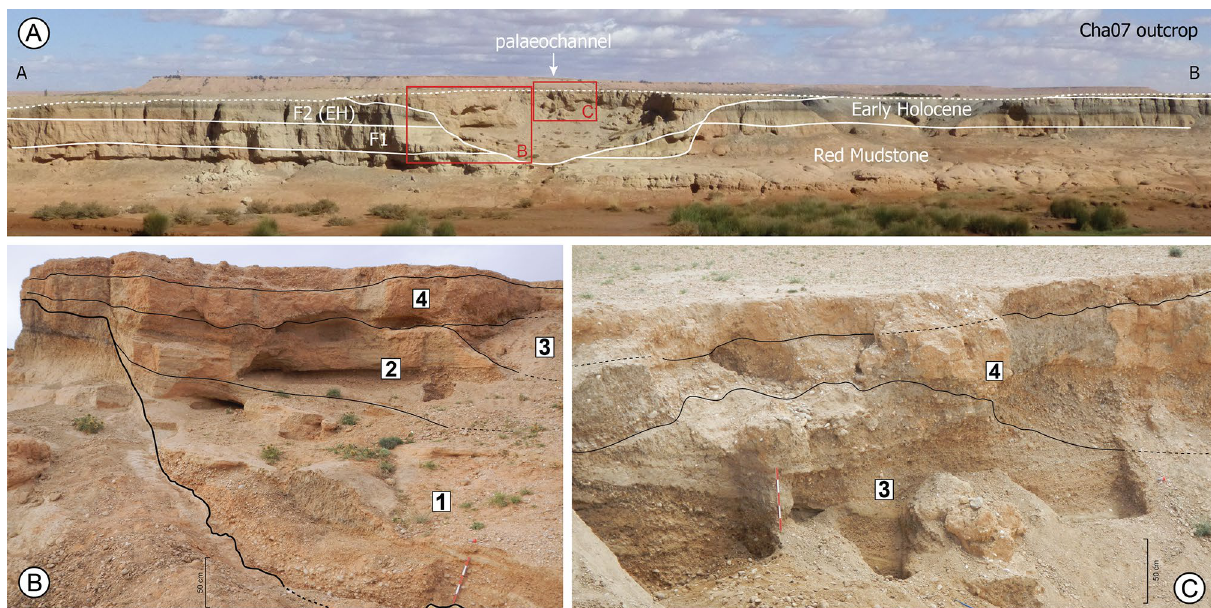
Figure 2. ( A ) Overview of the Cha07 outcrop, showing the Cha07 palaeochannel record and its incision into F2, F1, and the Red Mudstone formation. ( B , C ) Views of the palaeochannel infilling showing the limits and numbers of the fluvial sequences. The palaeochannel does not present a straight outcrop but has been hollowed out by erosion and has a platform at the top of the sequence 1. Data source: ( A – C ) pictures from D. Lefèvre, J.-F. Berger, and B. Depreux, respectively.